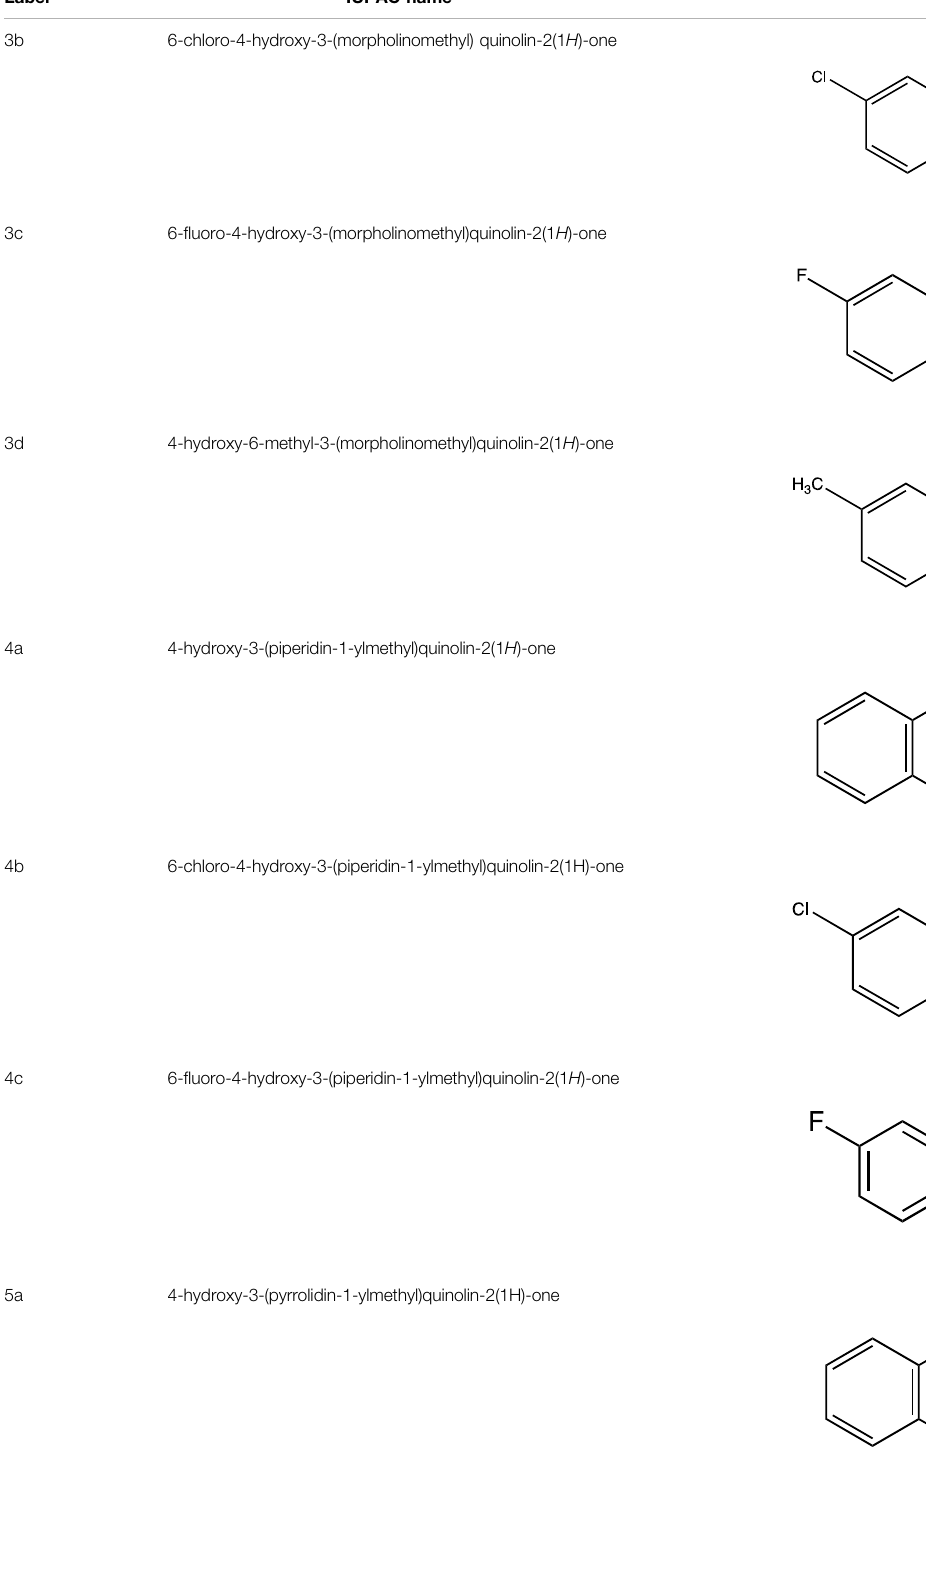
TABLE 1 | ( Continued ) Summary of the reagents, intermediates, synthesized compounds, their labels, IUPAC names and functional groups.